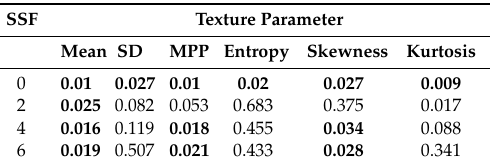
Table 2. Multivariate analysis results.